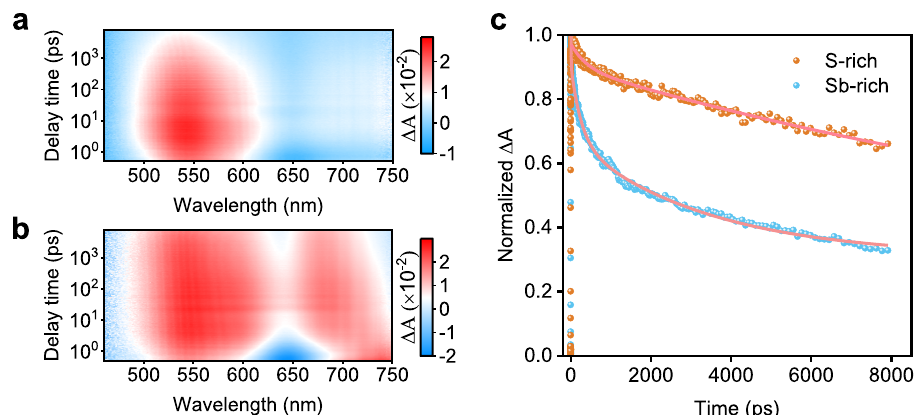
Fig. 6 Transient absorption spectroscopy (TAS) study of Sb 2 S 3 fi lms. a , b 2D color images of TAS of Sb-rich and S-rich Sb 2 S 3 fi lms on glass substrates. c Transient kinetic decay (scatter) and fi ttings according to biexponential decay function (solid lines) monitored at 545 nm of Sb-rich and S-rich fi lms. Δ A is de fi ned as variation of